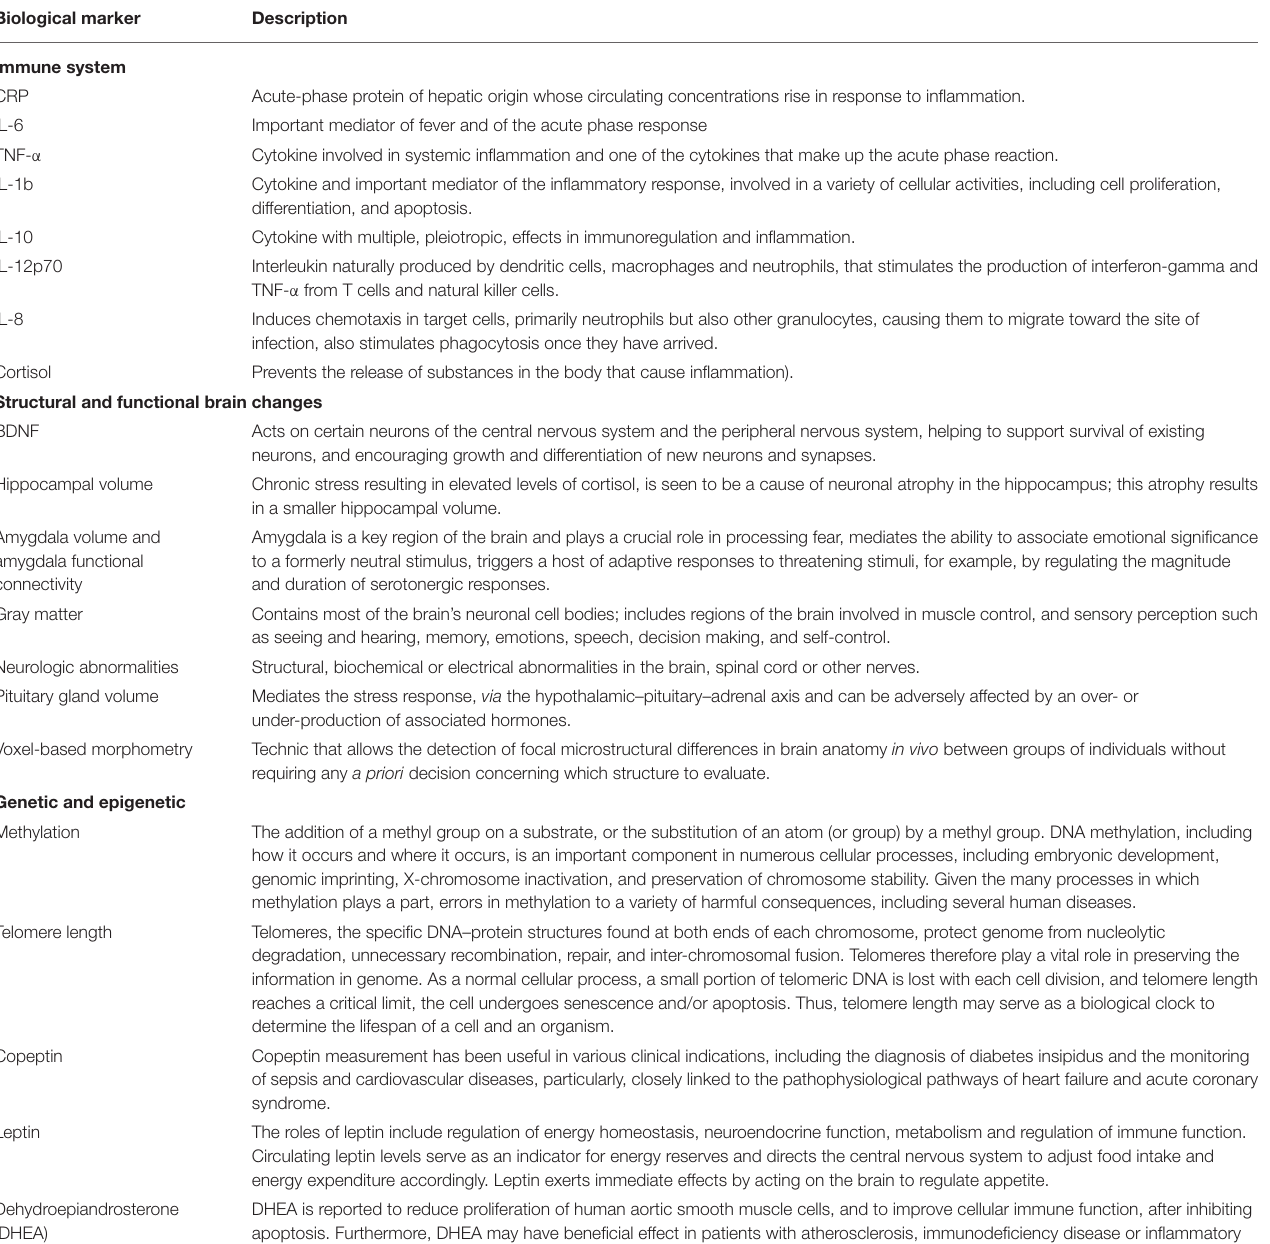
TABLE 1 | Description of biological markers divided by the biological